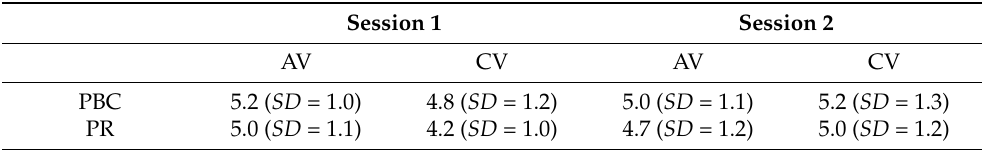
Table 3. Mean perceived behavioral control (PBC) and perceived risk (PR) scores per vehicle per session.